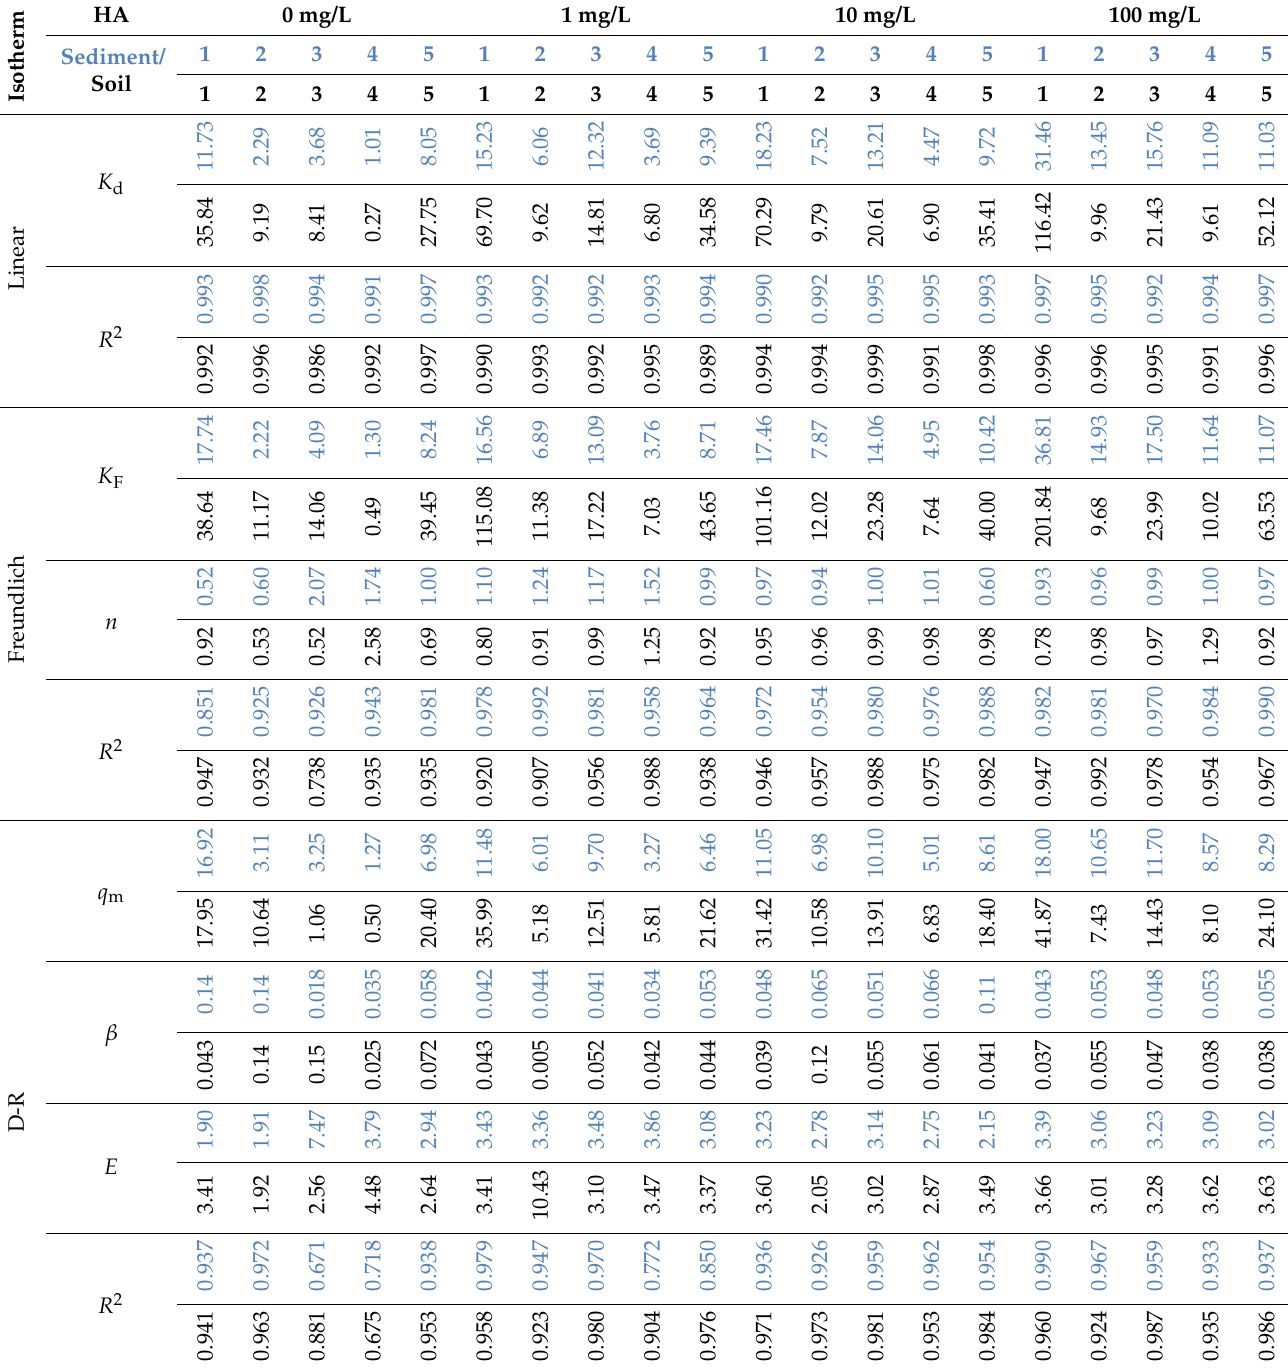
Table 3. The linear, Freundlich, and Dubinin–Radushkevich isotherm parameters for